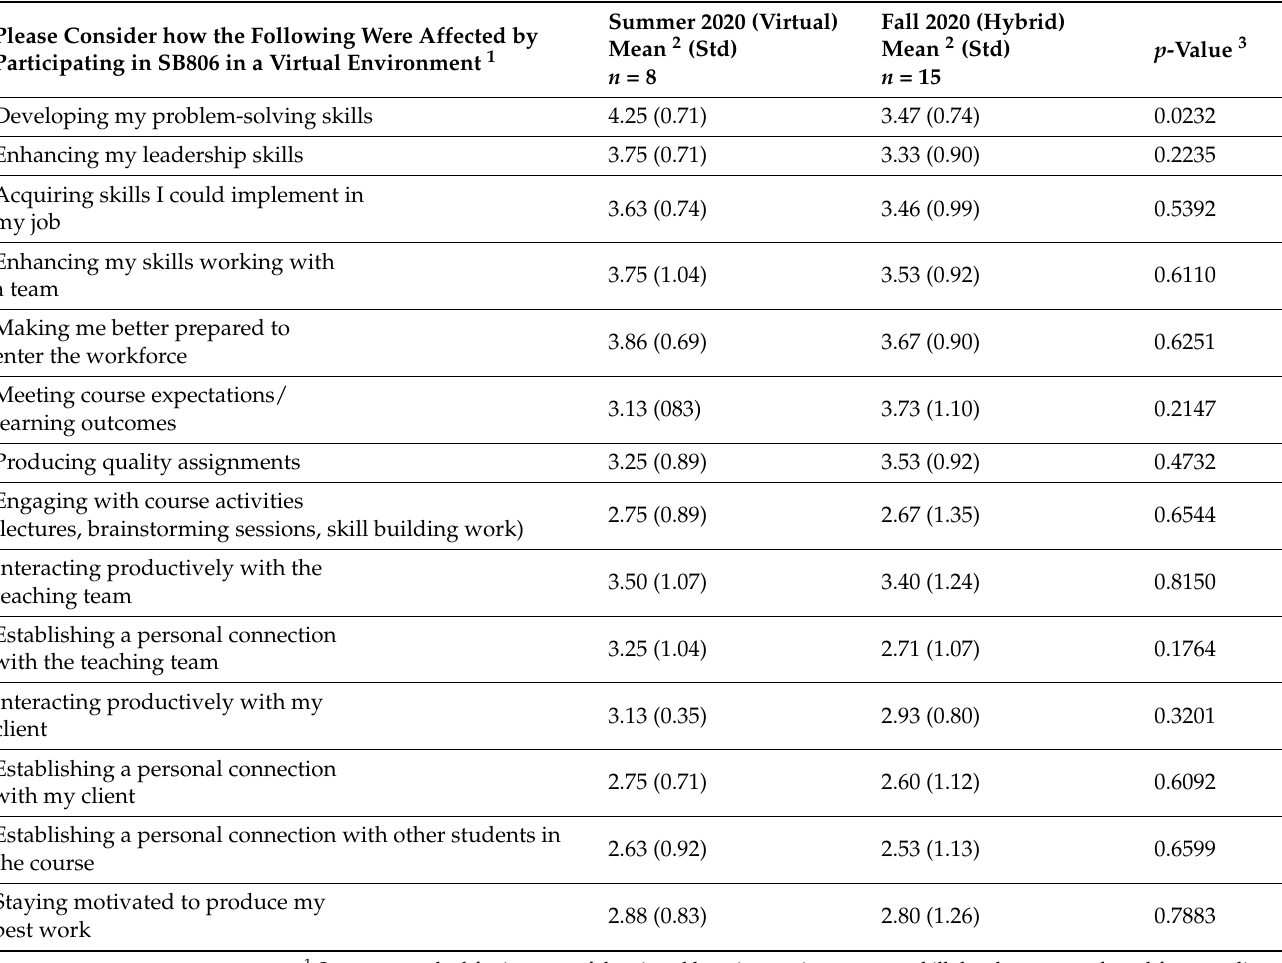
Table 5. Post-Course Student Assessment of Impacts of Virtual PBT Course on Skill Achievement across Three Semesters: In-Person, Virtual, and Hybrid ( n =